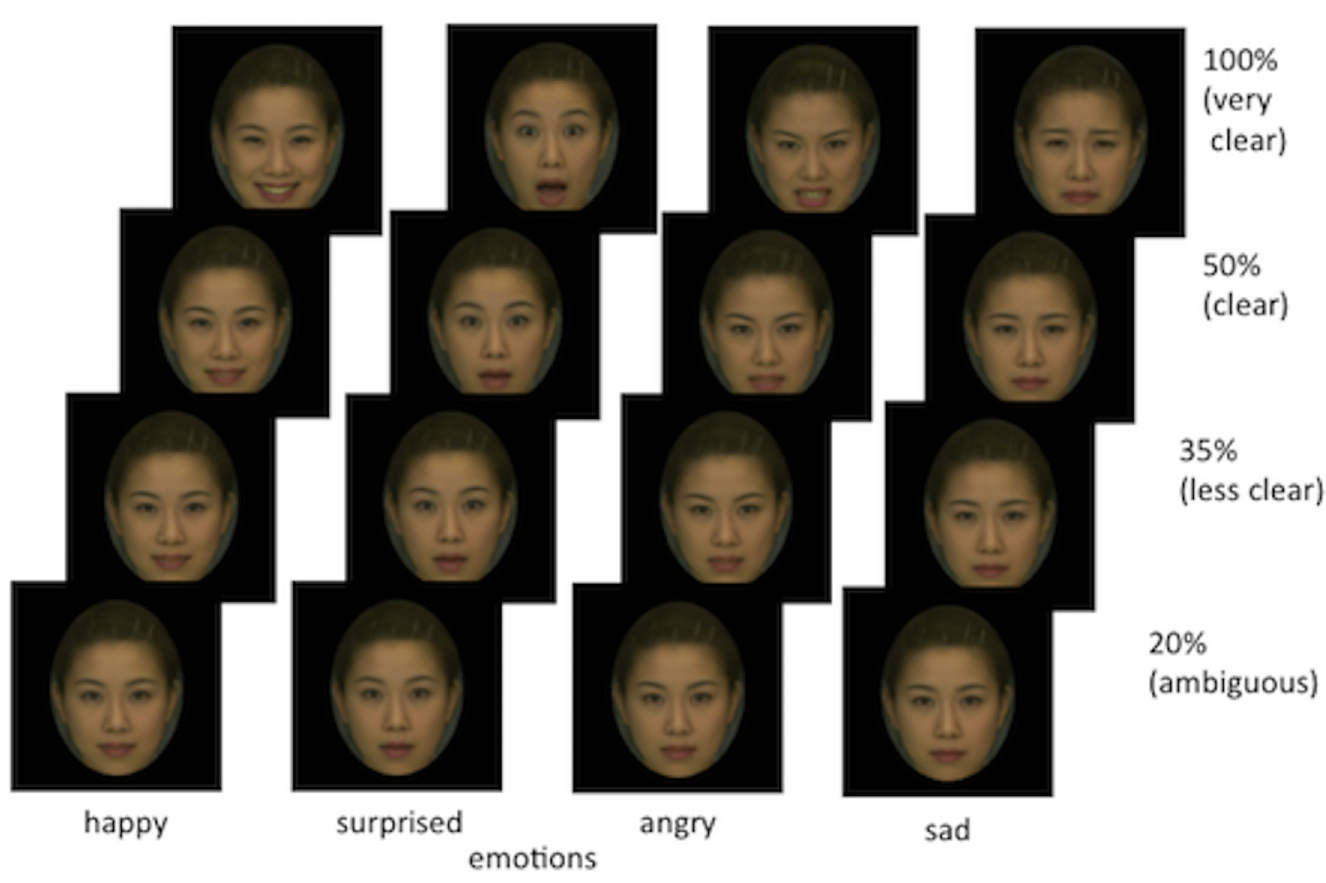
Fig 1. Emotional facial expressions used in the experiments and intensity of emotion from 20% (ambiguous), 35% (less clear), and 100% (clear). Note: Permission for publication of images was obtained by Hiroshi Yoshida. Publication of morphed images complies with the Terms of Use of the DB99 database.